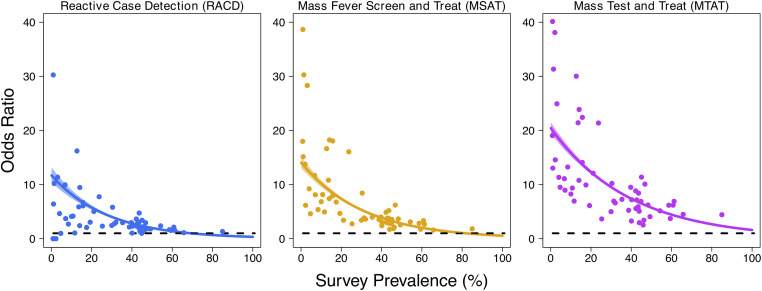
Malaria infection and the extent of household clustering according to detectability by different programmatic strategies.DHS data from 57 surveys and 23 countries detailing malaria infection status in children under 7 were collated, and the extent of infection clustering based on detectability by different programmatic strategies (RACD, MSAT or MTAT) was assessed. For each of these analyses, an individual was defined as residing in an index household if the household contained at least 1 other infection detectable through the programmatic strategy considered. The OR of being malaria positive in children who share a household with another child detectable through (A) RACD (clinical care seeking; population-level screening for infecton using routine diagnostics such as RDTs), (B) for the MSAT strategy (population-level recent fever screening), and (C) for the MTAT strategy (population-level screening for infecton using routine diagnostics such as RDTs) as compared to those who do not. Plots display the modelled OR (generated using a logistic-regression approach, coloured line) whilst points are the same ORs but calculated empirically for each survey. Pale shaded area represents the 95% CrI. CrI, credible interval; DHS, demographic health survey; MSAT, Mass Screen and Treat; MTAT, Mass Test and Treat; OR, odds ratio; RACD, Reactive Case Detection; RDT, rapid diagnostic test.